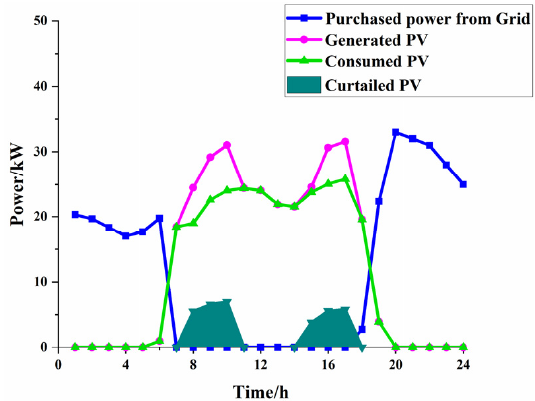
Figure 10. The power balance of PDN with the SA-CAES hub.